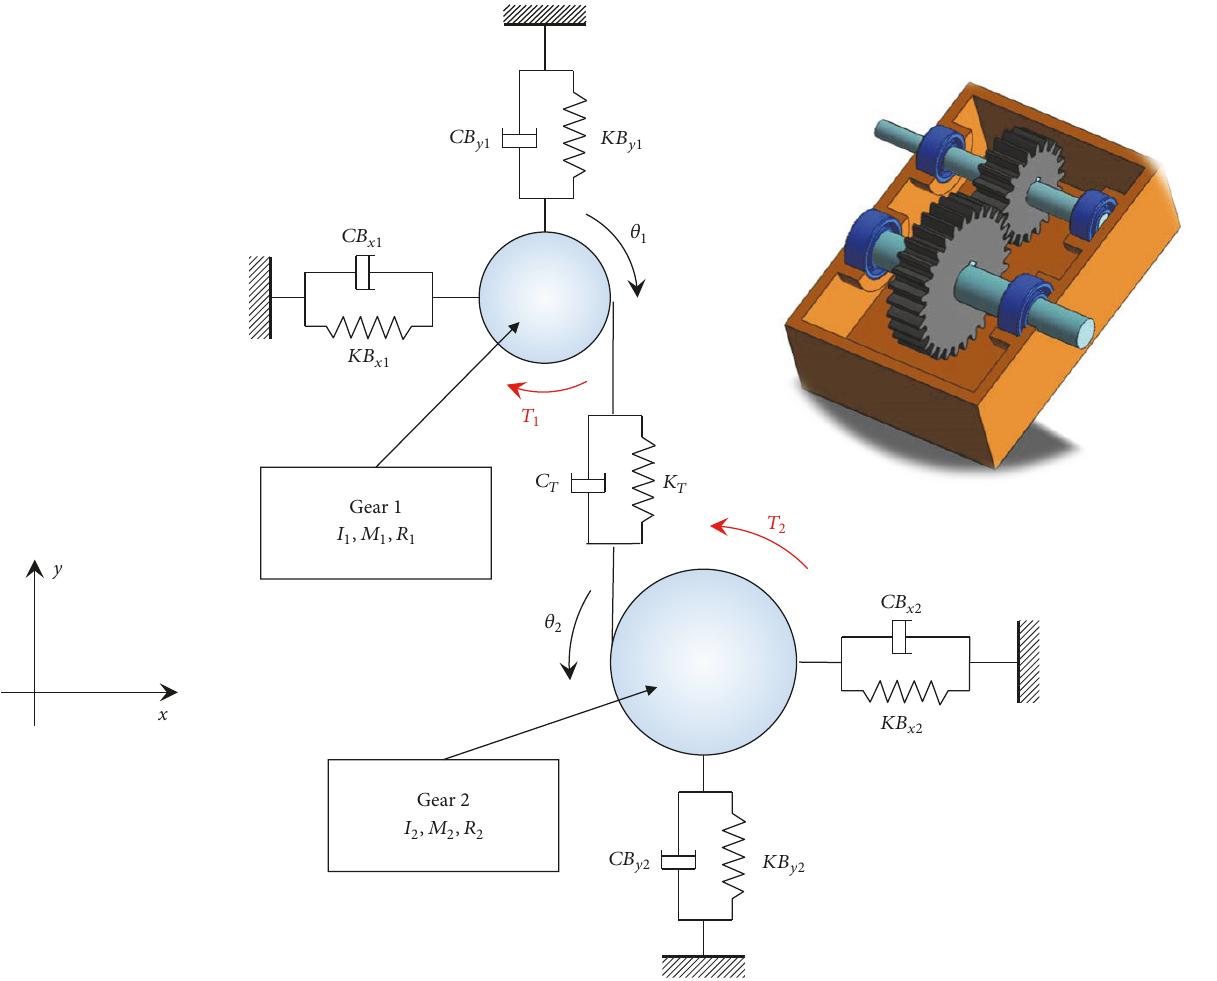
Figure 20: One-stage six-DOF gearbox dynamic model